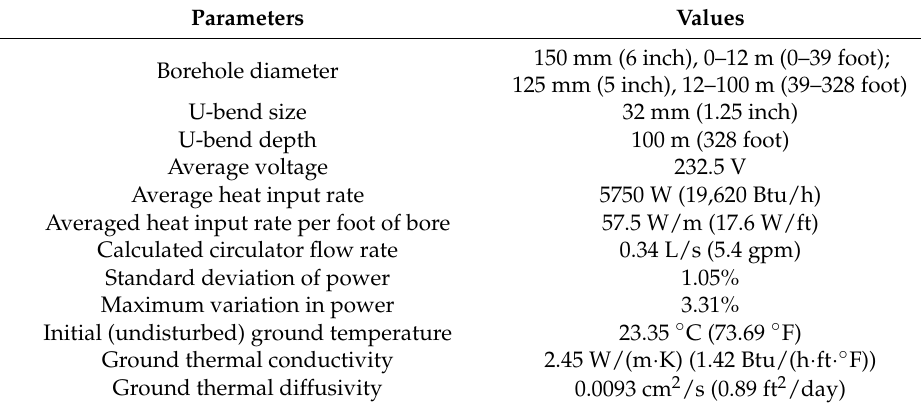
Figure 3. Thermal conductivity test measurements of loop water temperatures and heating rate vs. time. Table 3. Summary of the thermal conductivity test statistics for 24–48 h and results of analysis.